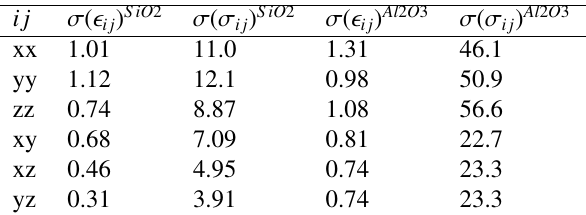
Table 1. Strain and stress tensor standard deviations,  , for quartz (SiO2) and sapphire (Al2O3), as described in text. Strain in units of 10  4 and stress in units of